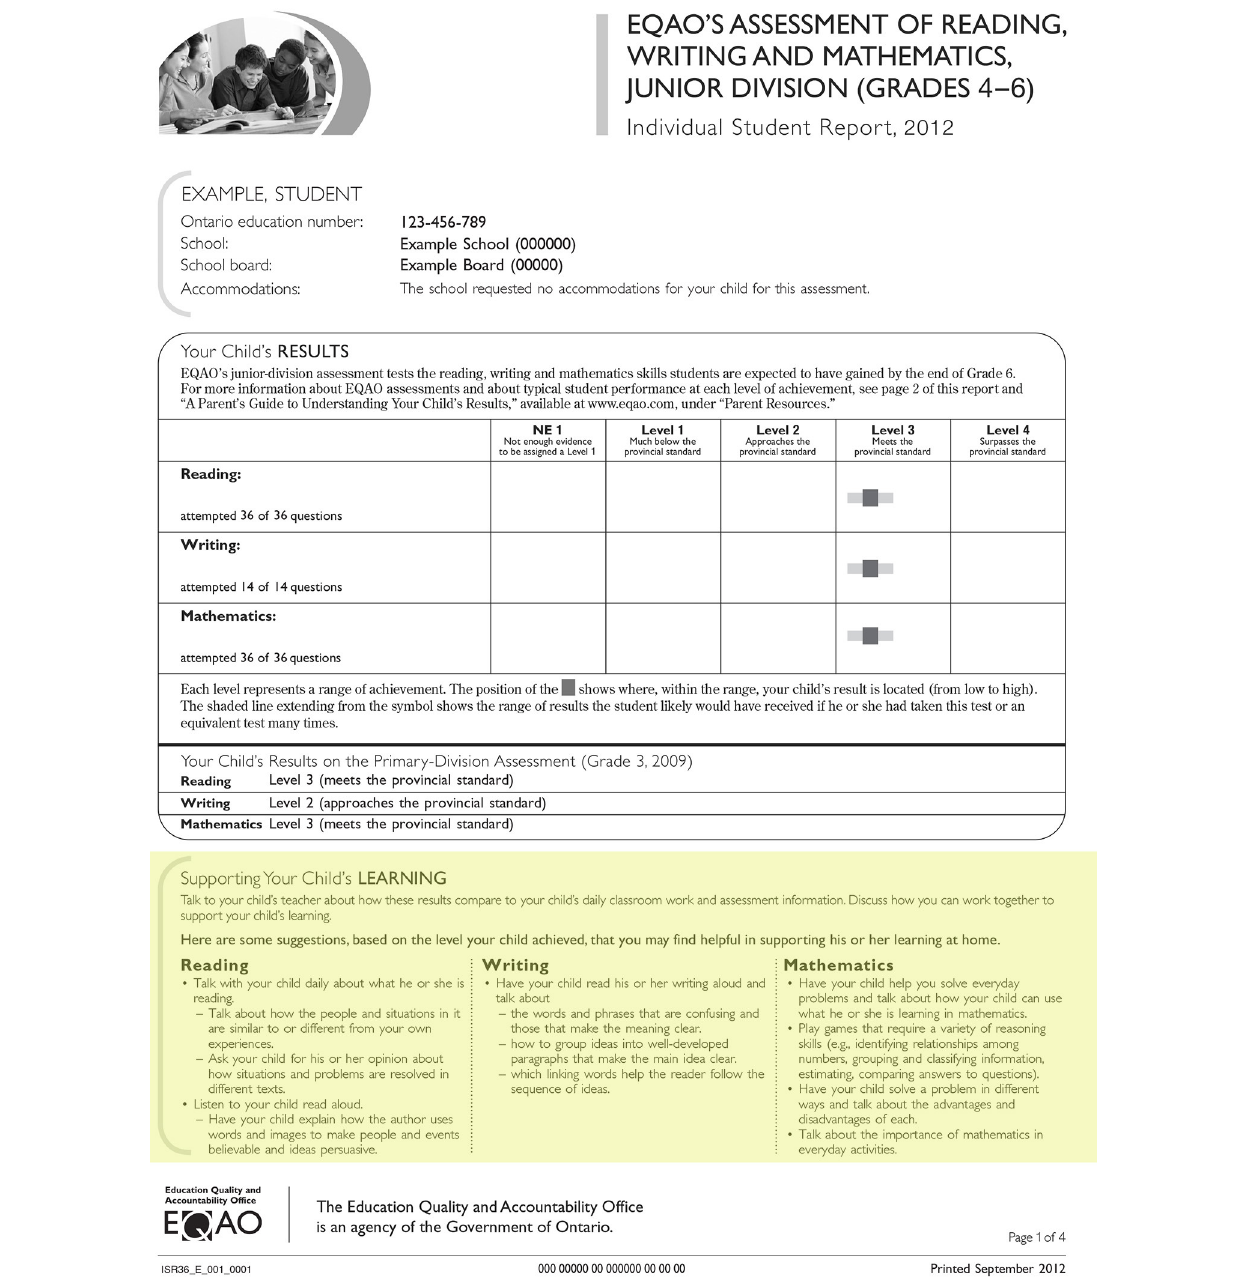
FIGURE 5 | Strategies to support the child’s learning (highlighting added) were presented on the front page of the Ontario Individual Student Report. Used by permission of the Education Quality and Accountability Office. All rights reserved.